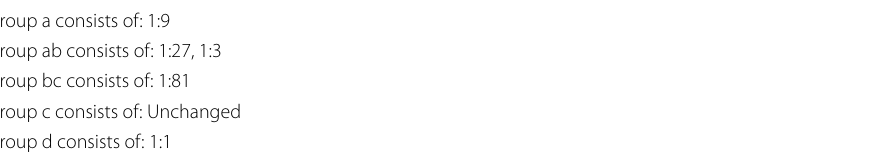
Table 32 HSD test groupings after ANOVA of AUC for the RUS factor